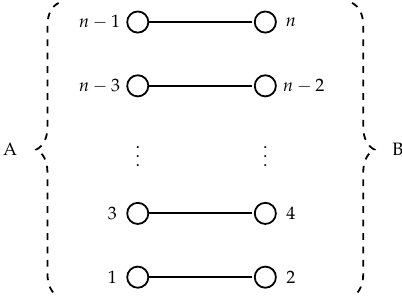
Figure 5. The bipartite graph G